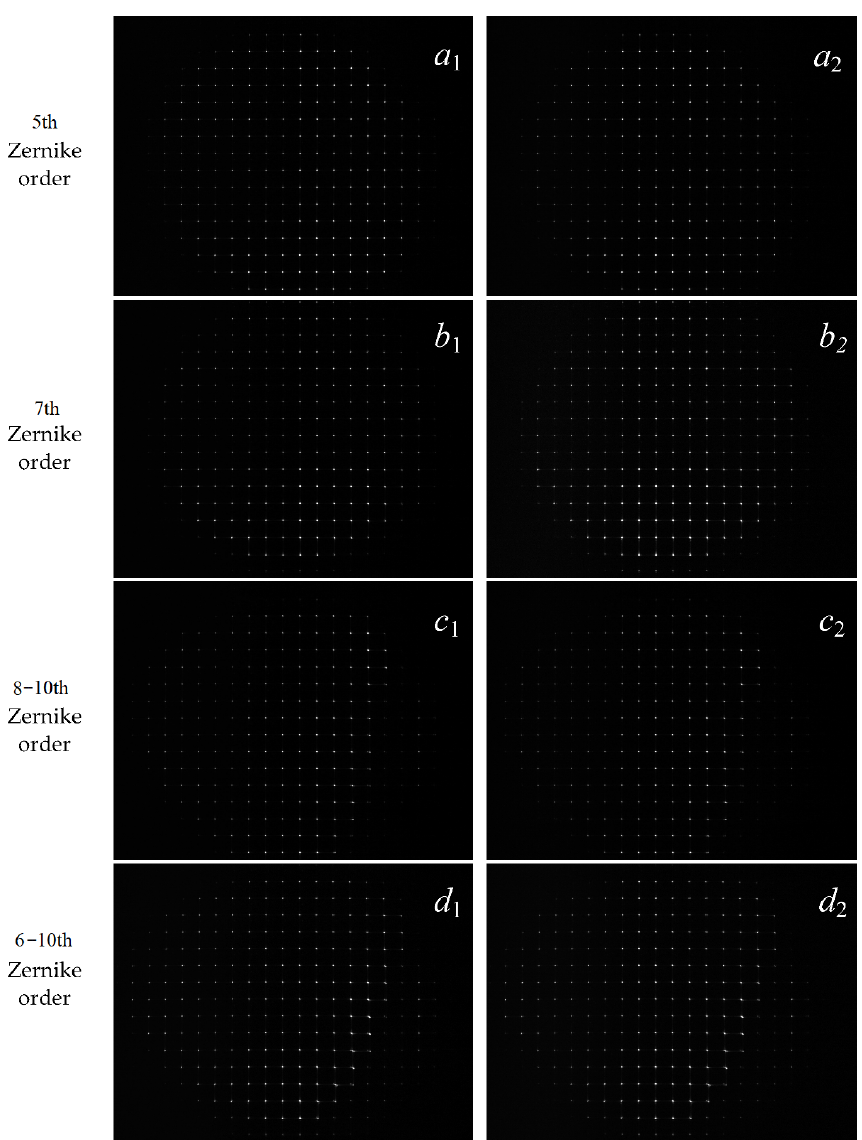
Figure 13. The images captured by SH sensor with different Zernike orders where ( a 1 , b 1 , c 1 , d 1 ) denote the images without noise, respectively; ( a 2 , b 2 , c 2 , d 2 ) denote the images with noise, respectively.